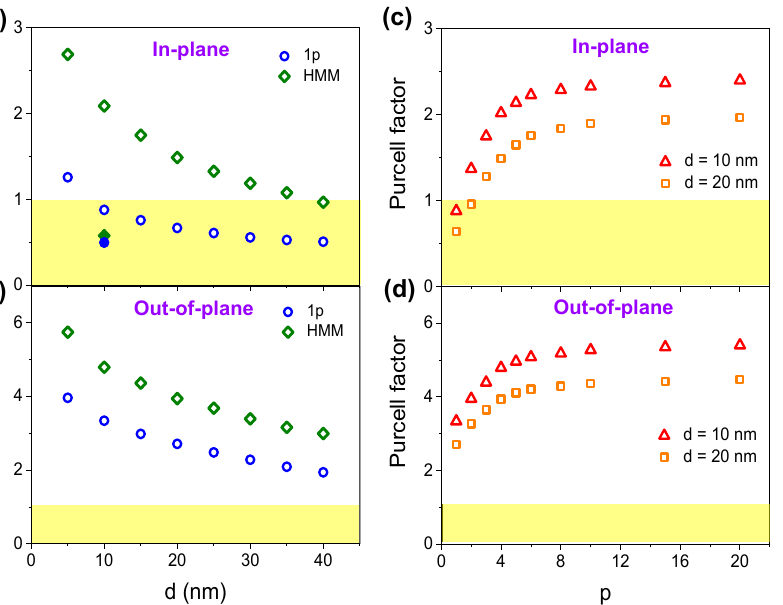
Figure 2: Dipole orientation dependent Purcell factor in the presence of metamaterials. (a, b) Calculated Purcell factors at a wavelength of 750 nm as a function of d in the presence of 1p and HMM substrates for in-plane (a) and out-of-plane dipoles (b), respectively. Filled dots in (a) show experimental results. (c, d) Calculated Purcell factors as a function of p at d = 10 and 20 nm for in-plane (c) and out-of-plane dipoles (d), respectively. The yellow region indicates that the Purcell factor is less than